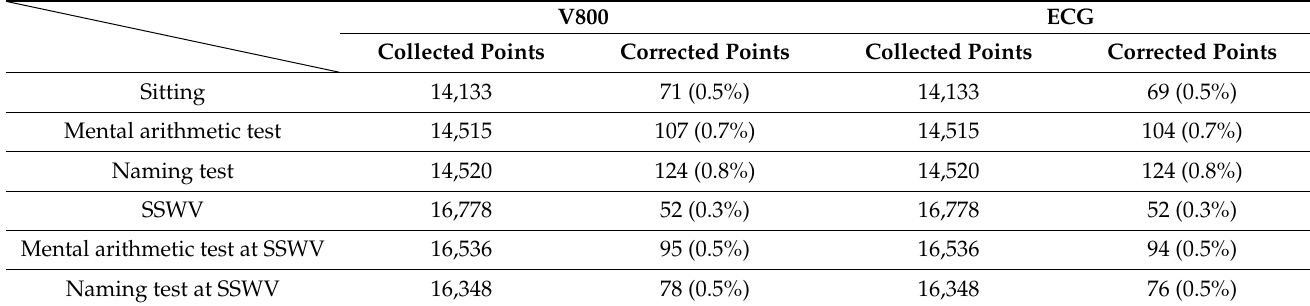
Table 2. The total number of R-R intervals detected and corrected.